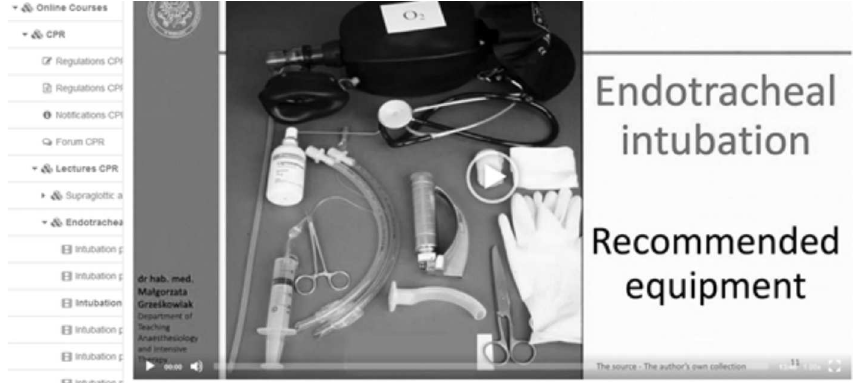
Figure 8. The use of pictures/figures in an e-learning presentation to demon- strate the recommended equipment for endotracheal intubation